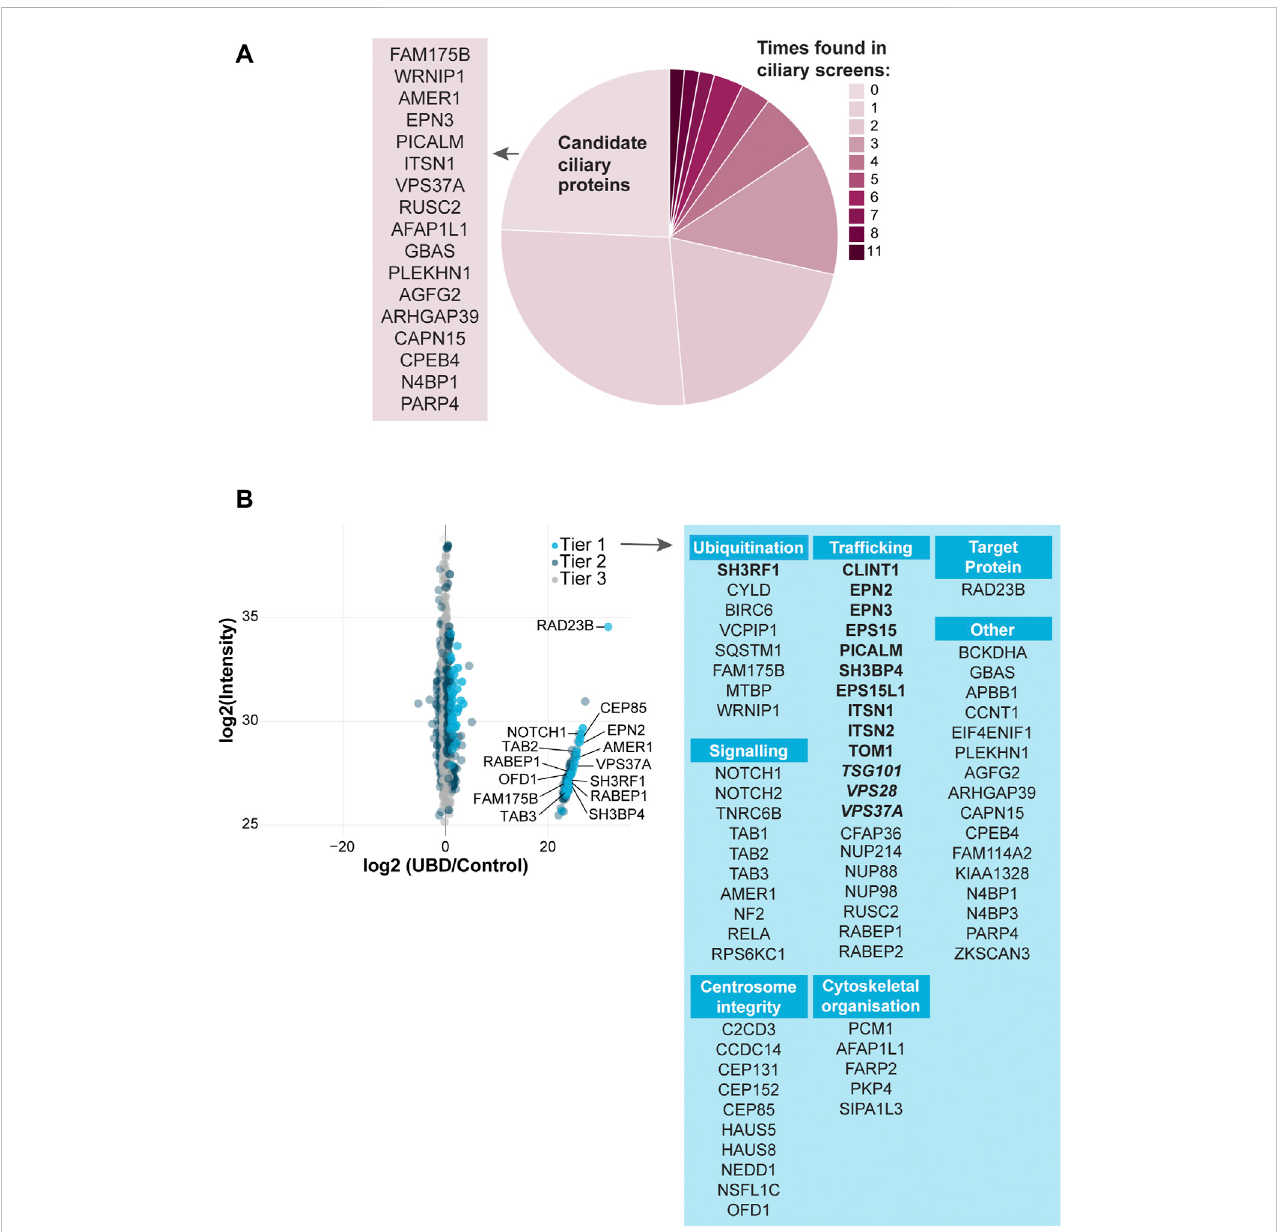
AnalysisofUBDmassspectrometryresults (A) Comparisonofthesigni fi cantlyenrichedproteinsfromtier1withpublishedciliary-datasets.Mostproteins were previously identi fi ed in other ciliary studies, of which OFD1, C2CD3, PCM1, CEP131, and SQSTM1 were identi fi ed most often (dark pink). The remaining proteins are indicated as “ New candidate ciliary proteins ” on the left of the pie plot (B) MS analysis of enriched proteins in the UBD versus the control cell line after proximity labelling. The proteins are colored according to their signi fi cance tier. All Tier 1 signi fi cant proteins were grouped by function (light blue), for which the clathrin-related proteins (bold) and ESCRT proteins (bold italic) are highlighted. The complete list of identi fi ed proteins (Tier 1, 2, and 3) can be found in Supplementary Table